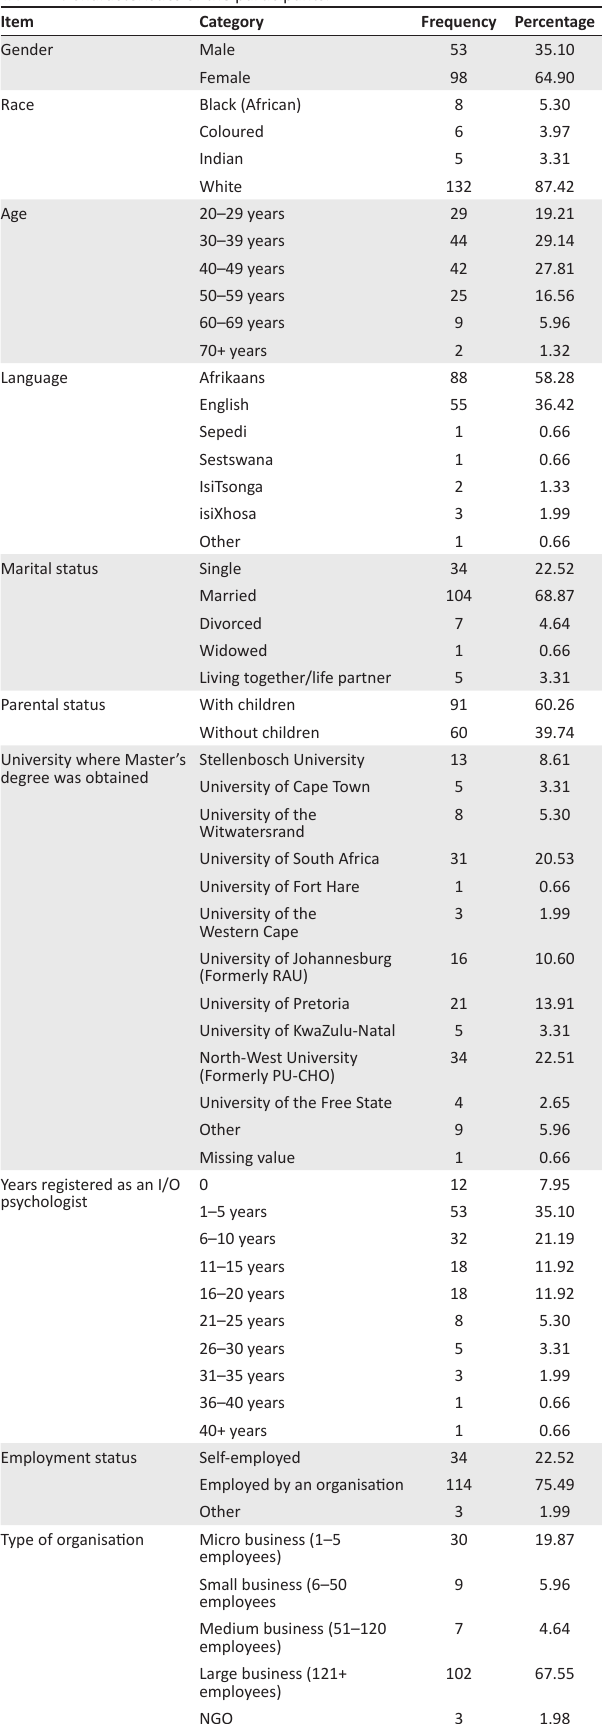
TABLE 1: Characteristics of the